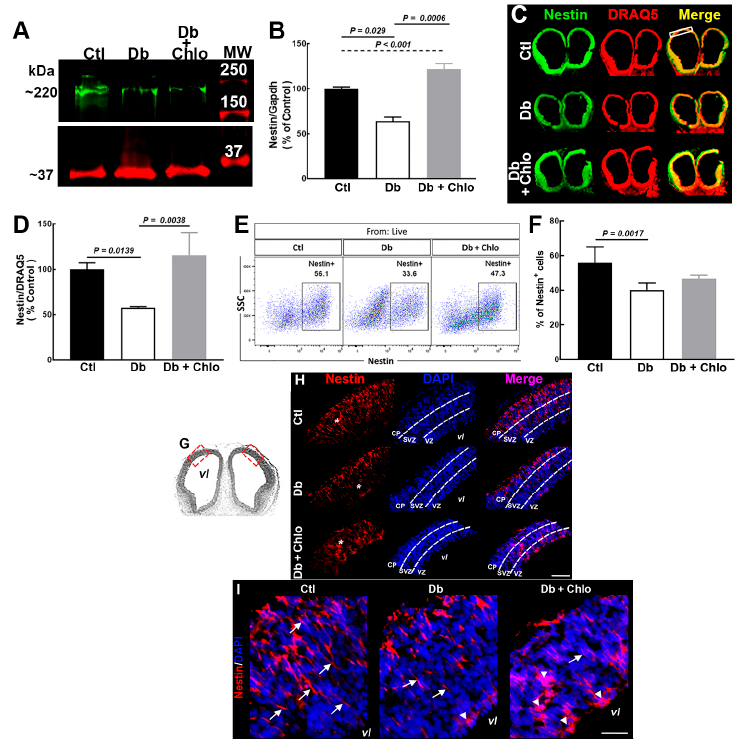
Figure 4. Nestin positive cell analysis in the cortical neuroepithelium and of 14-day-old embryos. ( A ) Representative Nestin (radial glia, green, ~220 kDa) Western blots of control (Ctl), diabetic (Db), and chlorpheniramine-treated diabetic (Db + Chlo) groups of E14 dorsal telencephalic tissue. GAPDH (red, ~37 kDa) was used as an internal control. ( B ) Quantitative fluorometry analysis of Nestin. Values (means ± S.E.M., n = 4) are expressed as a percentage of the control fluorescence ratio. C) Nestin (green) representative immunofluorescence images of coronal sections from Ctl, Db, and Db + Chlo of E14 coronal sections. DRAQ5 (red) staining was used as the internal control. ( D ) Quantitative fluorometry analysis for Nestin in the dorsal telencephalon (white rectangle in ( C )). Values (means ± S.E.M., n = 4) are expressed as a percentage of the fluorescence ratio of controls. ( E ) Nestin + cells representatives flow cytometry in cells obtained at E14 from the dorsal telencephalon of Ctl, Db, and Db + Chlo groups. ( F ) Quantitative analysis of Nestin + cells. Values (means ± S.E.M., n = 4) are expressed as the percentage of the total positive cells. For ( B , D , F ), the two-way ANOVA, followed by Tukey’s multiple comparison test was performed, and the significant P values are shown in the graphs. ( G ) Hematoxylin-eosin-stained coronal section of E14 telencephalon represents the cut level used in the immunodetection. ( H ) Representative micrographs (20×) of Nestin mark (red) and DAPI stained nuclei (blue) from E14 coronal slices of control (Ctl), diabetic (Db), and chlorpheniramine-treated diabetic (Db + Chlo) groups. Cortical plate = CP, subventricular zone = SVZ, ventricular zone = VZ, and vl = ventricular lumen. Scale bar = 100 μ m in H and 50 μ m in ( I ). ( I ) Electronic zoom (300%) of the micrographs in ( H ) from the zone marked with the white asterisk. The white arrows show Nestin projections and arrowheads aberrant Nestin aggregation.